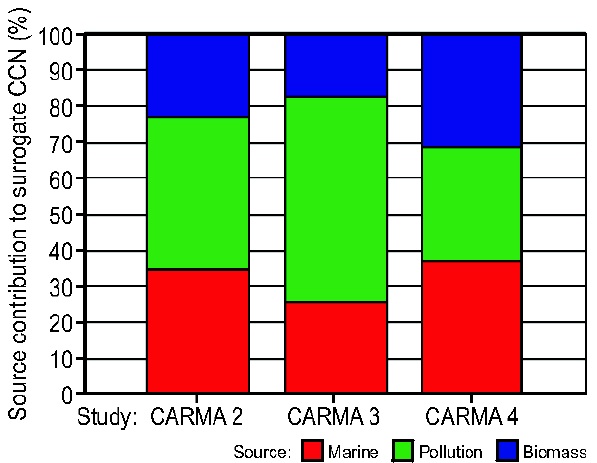
Figure 13. Study average source contributions by each of three source categories Fig. 12. Study average source contributions by each of three source (see text) to the aerosol light-scattering coefficient (Bsp). Uncertainties associated categories (see text) to the surrogate CCN(0.3%) concentration. Un- certainties associated with the mean source estimates are given in with the mean source estimates are given in Table 3. Table 3.